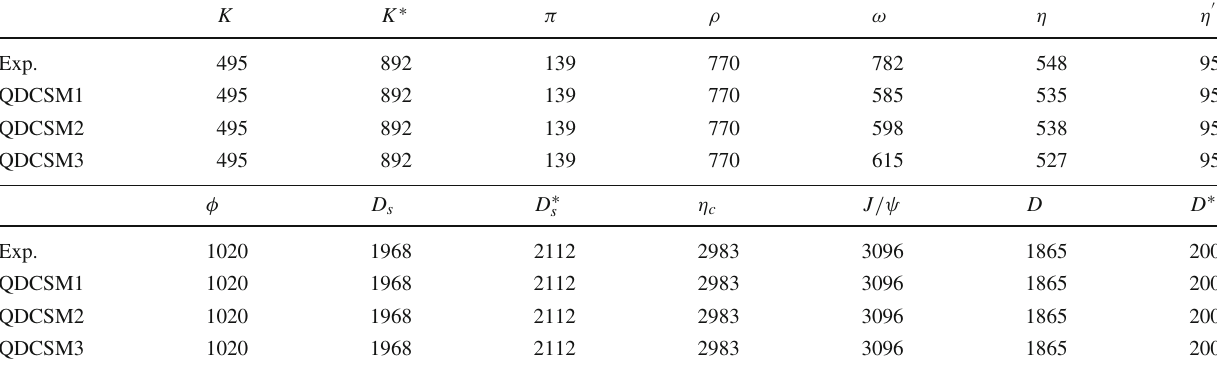
Table 2 The masses (in MeV) of the ground mesons. Experimental values are taken from the Particle Data Group (PDG)